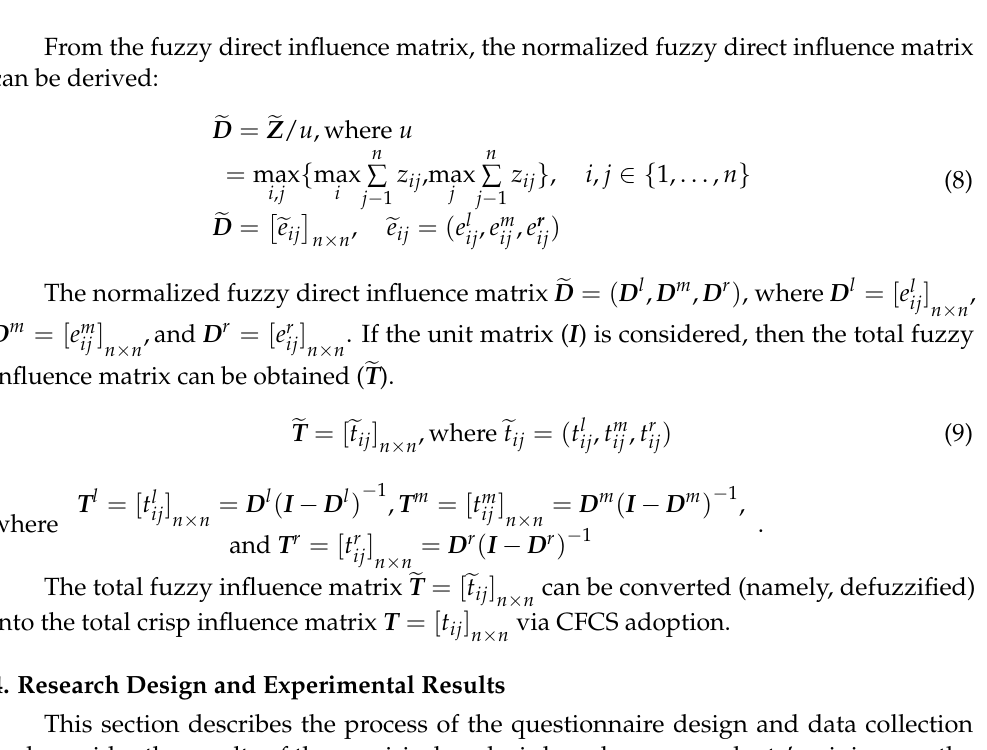
Table 2. The linguistic scale for the influence of criteria (Opricovic and Tzeng [56]). Linguistic Term Triangular Fuzzy Numbers No influence [0, 0.1, 0.3] Weak influence [0.1, 0.3, 0.5] Medium influence Strong influence [0.5, 0.7, 0.9] Very strong influence [0.7, 0.9,